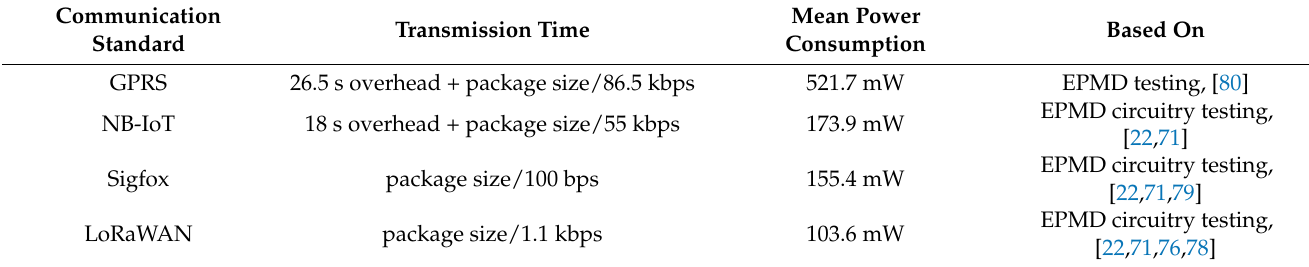
Table 5. Assumptions for power consumption during data